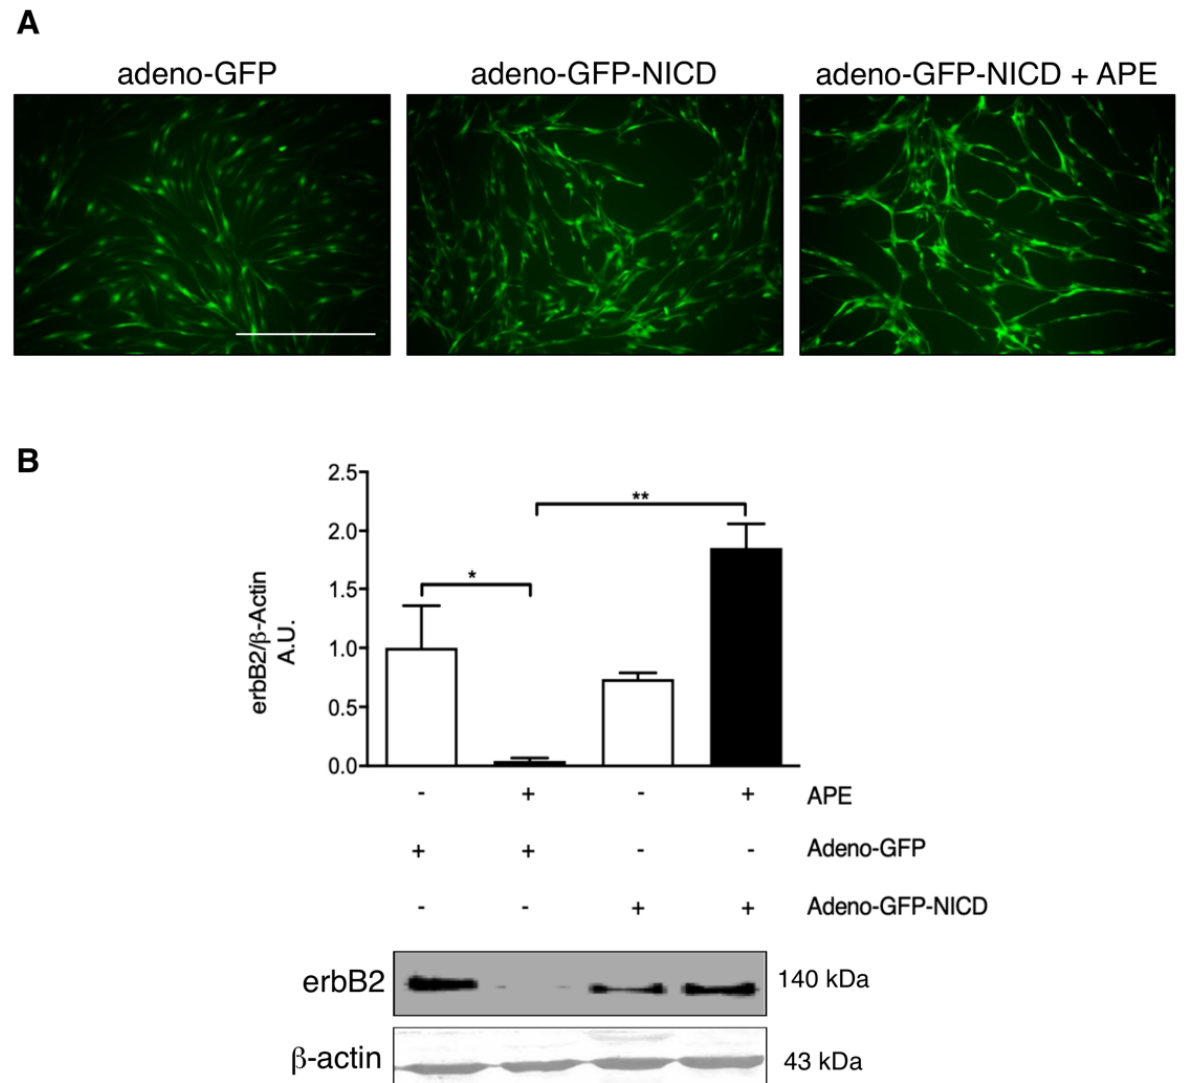
Figure 5. Analysis of erbB2 expression in SCs infected with Notch-NICD adenovirus in absence and in presence of M2 agonist treatment. ( A ) Representative fluorescence microscope images showing adenovirus-infected SCs expressing the adenovirus-GFP or adenovirus-NICD-GFP-constructs in control conditions and after 24 h of 100 µ M APE treatment. In all pictures, SCs present the characteristic spindle-like cell morphology and a high percentage of infection (scale bar = 200 µ m). ( B ) Densitometric analysis of the bands of erbB2 expressed in SCs infected with either the adenovirus-GFP or the adenovirus NICD-GFP constructs and subsequently treated with 100 µ M APE when required from the experimental plan. β -actin was used as the internal reference protein. Data represent the average ± SEM of at least three independent experiments (* p < 0.05, ** p < 0.01; n = 3). Below the graph, representative Western blot analysis for erbB2 in SCs after infection with adenovirus-GFP or adenovirus-NICD-GFP, in the absence or presence of 100 µ M APE for 24